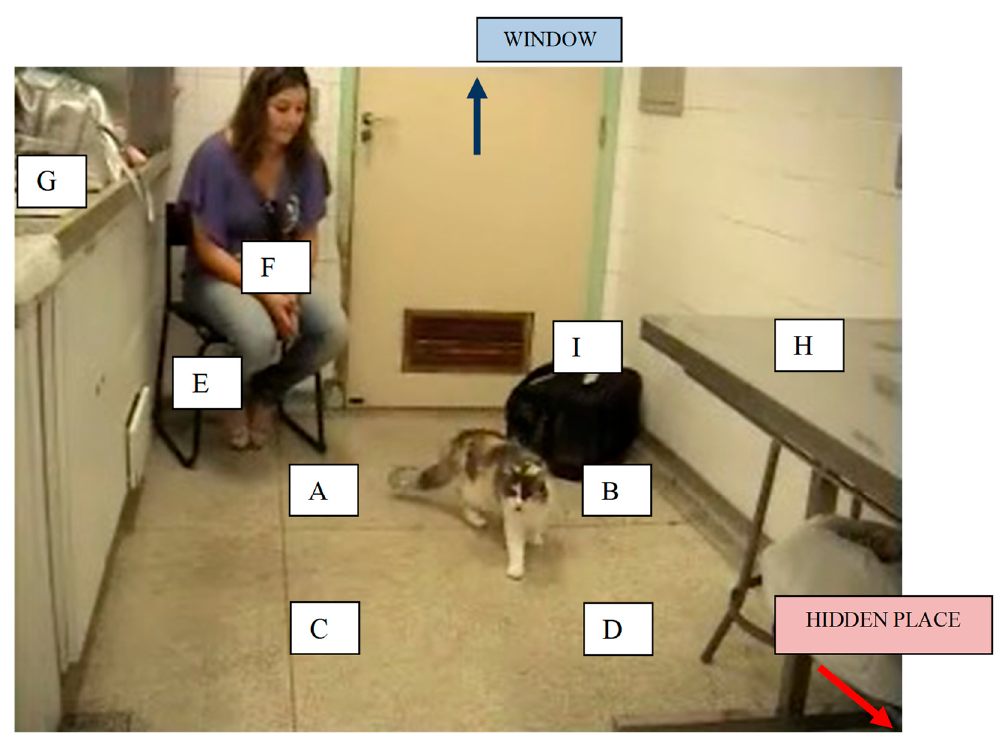
Figure 2. Dedicated room where the recording took place. Locations are identified by letters A–I. Hidden place: from a window at the door, it was possible to register the moment the cat went from out of view to the hidden place location. This was under a medical cabinet located in the